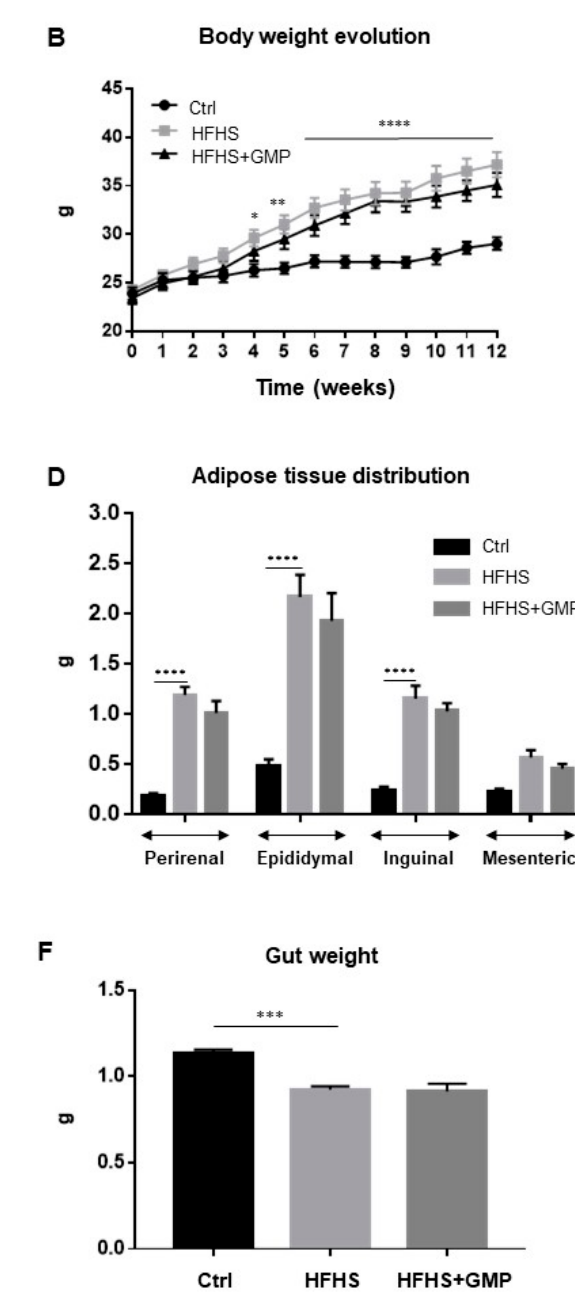
Figure 1. Impact of GMP on energy intake, body weight and body composition. Mice were fed either a standard chow diet (Ctrl) or a high-fat, high-sucrose diet (HFHS) for 12 weeks. HFHS-fed animals were treated with glycomacropeptide (GMP, 200 mg/kg body weight/day) by gavage (HFHS+GMP). Ctrl and HFHS-fed mice were gavaged with a water-vehicle. ( A ) Energy intake; ( B ) Body weight evolution; ( C ) Whole body adiposity; ( D ) Adipose tissue distribution; ( E ) Liver and ( F ) Gut weights were evaluated as described in Material & Methods. Data are expressed as the mean ± SEM for n = 10 mice/group. * p < 0.05, ** p < 0.01, *** p < 0.001, **** p < 0.0001 vs. Ctrl mice.